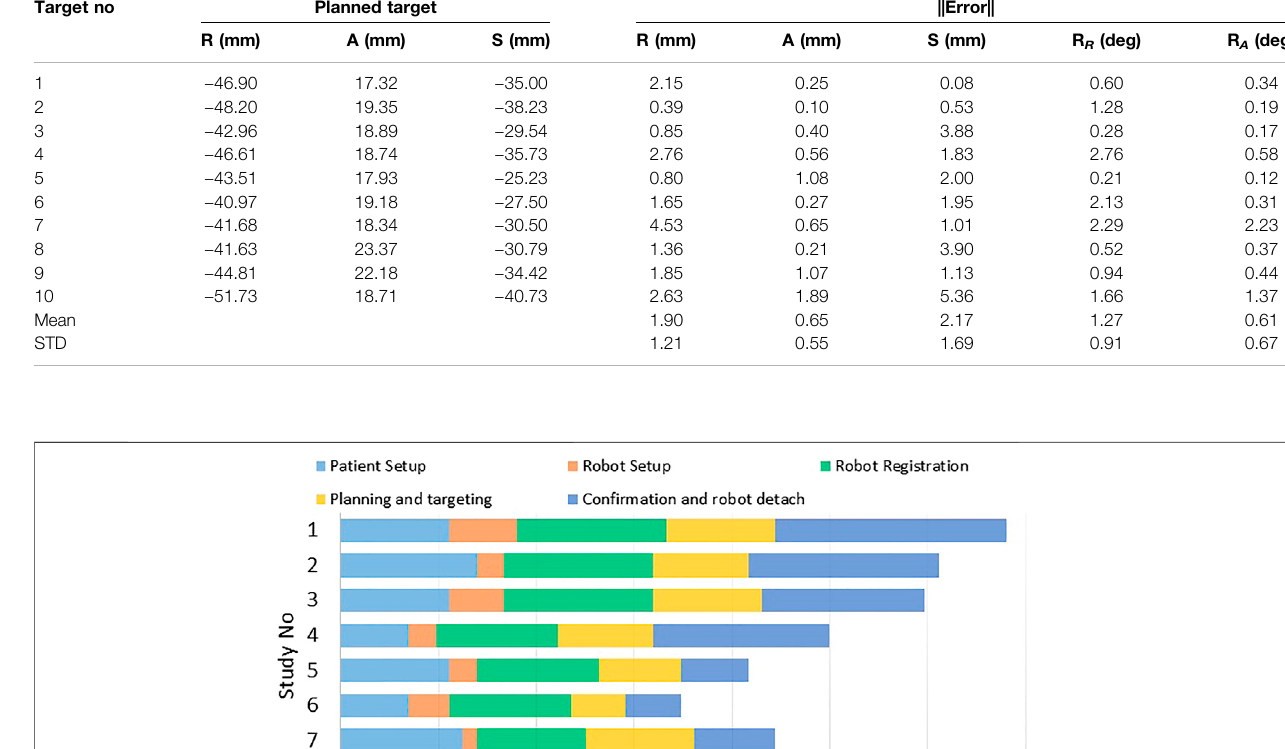
TABLE 1 | Results from 10 targeting attempts showing position and orientation errors. Target no